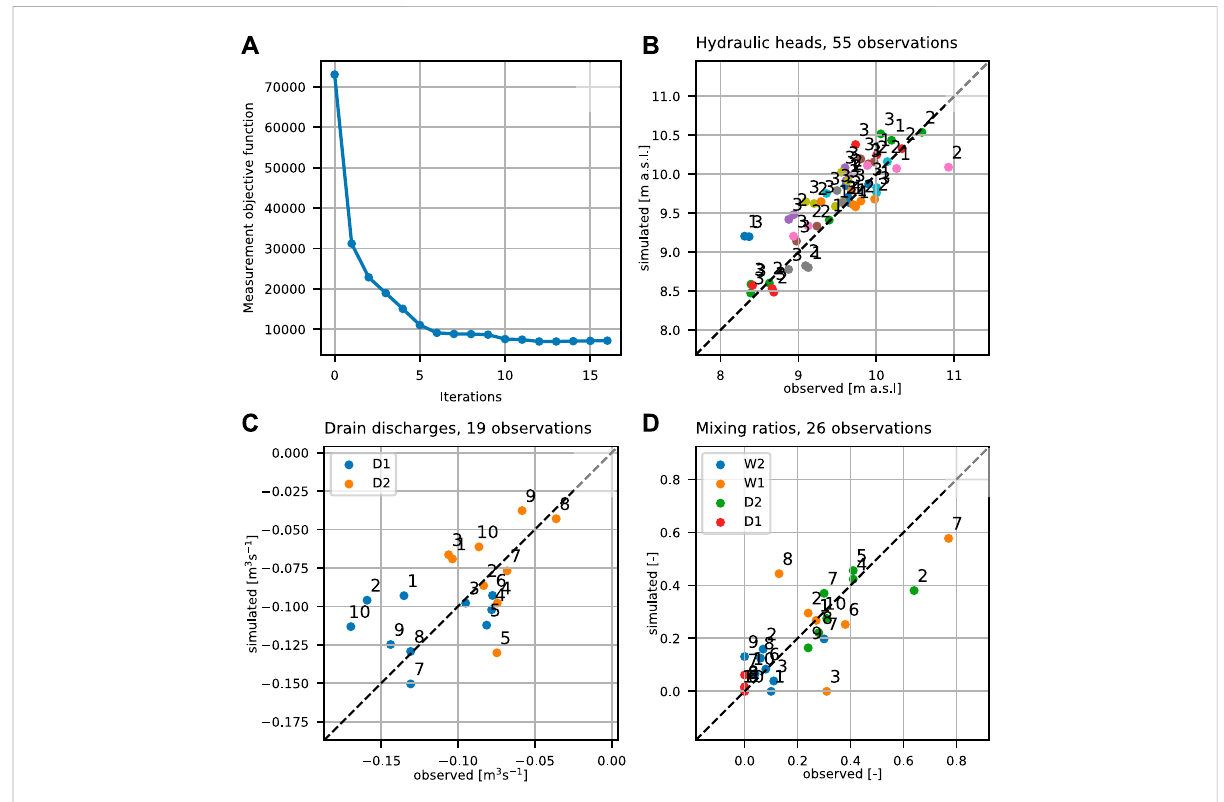
FIGURE 8 Results of the parameter estimation with the GLMA. (A) Evolution of the measurement objective function throughout GLMA iterations. Simulatedversusmeasuredhydraulicheads (B) , draindischarges (C) ,and mixingratios (D) .Numbersin (B,C,D) referto thesurveys; colors in (B) refer to the observation